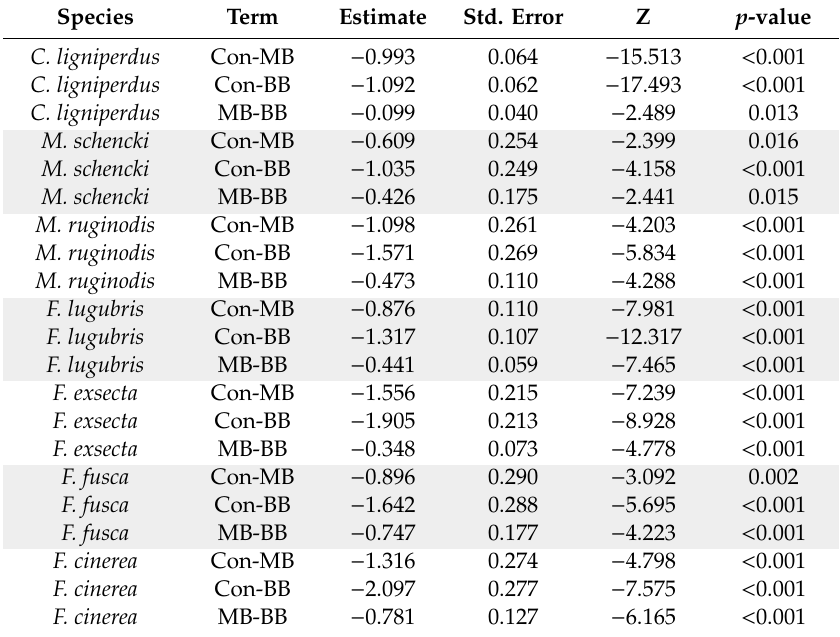
Figure 4. Effect of blocked metapleural glands on survival. Comparisons in survival between four treatments of F . sanguinea ants. Colored bands denote 95% confidence intervals. Table 1. Survival analysis. Comparisons in survival between control ants (Con), ants exposed to B . bassiana (BB), and ants exposed to M. brunneum (MB).